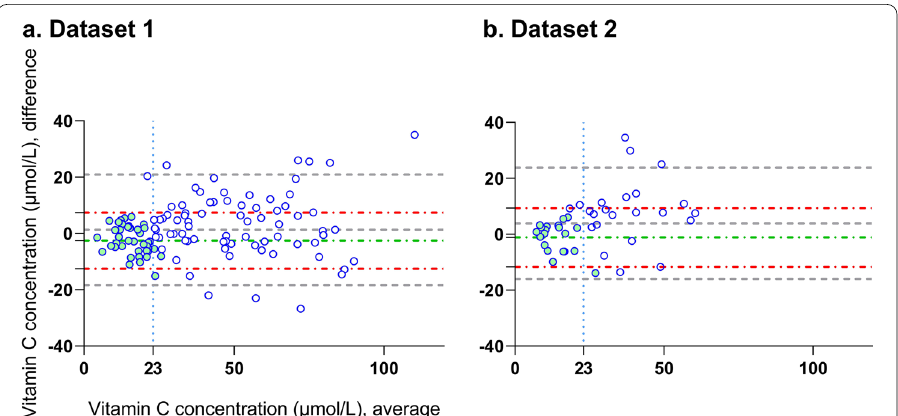
Fig. 3 Bland–Altman plots of dataset 1 ( a ) and dataset 2 ( b ). The X‑axes represent the average of the estimated plasma vitamin C concentration by our model and the measured plasma vitamin C concentration with HPLC (gold standard). The Y ‑axes represent the difference between the two measurements. The mean bias and its confidence limits (limits of agreement, LoA) are shown for the whole group (gray striped lines) and subgroup (< 23 µmol/L, green filled dots) analysis (mean bias dotted striped lines)